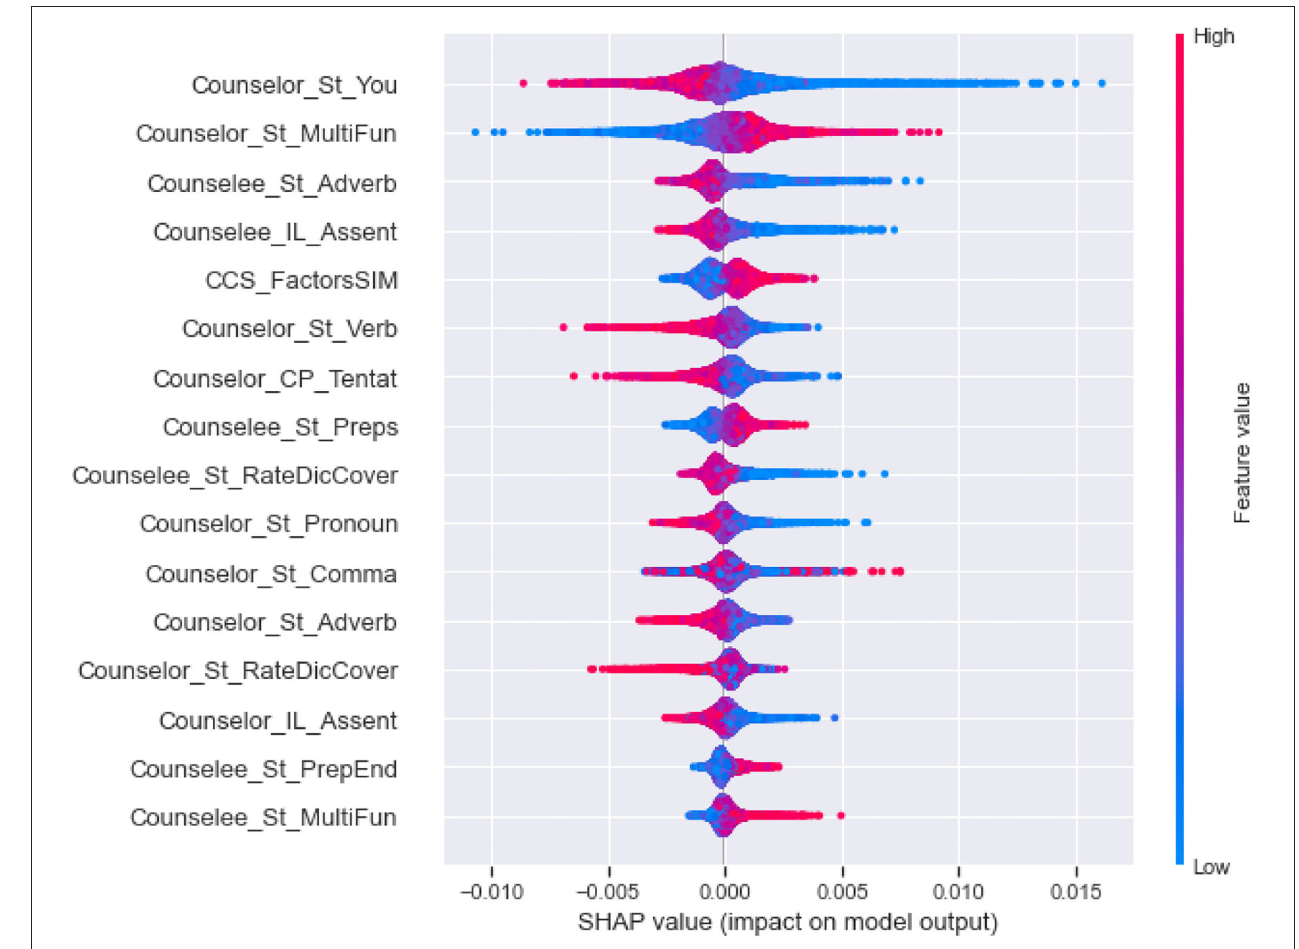
FIGURE 8 | The SHAP summary plots about the adjustment to the predicted in perceive helpfulness numbers (x-axis) for each of the fifth type